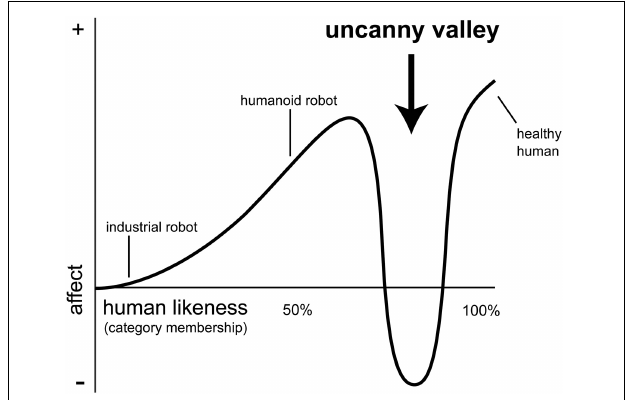
FIGURE 1 | The N-Shaped Uncanny Valley function, as proposed by Mori (1970) (illustration adapted from MacDorman,